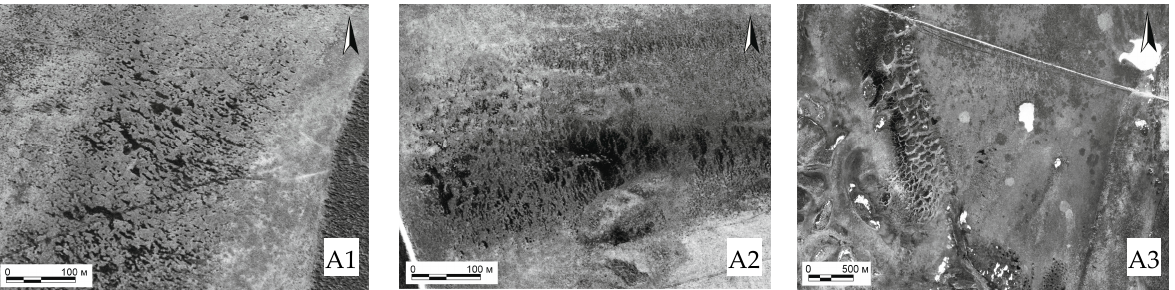
Figure 2. Satellite image of string-flark patterns. A1–A3 sites.